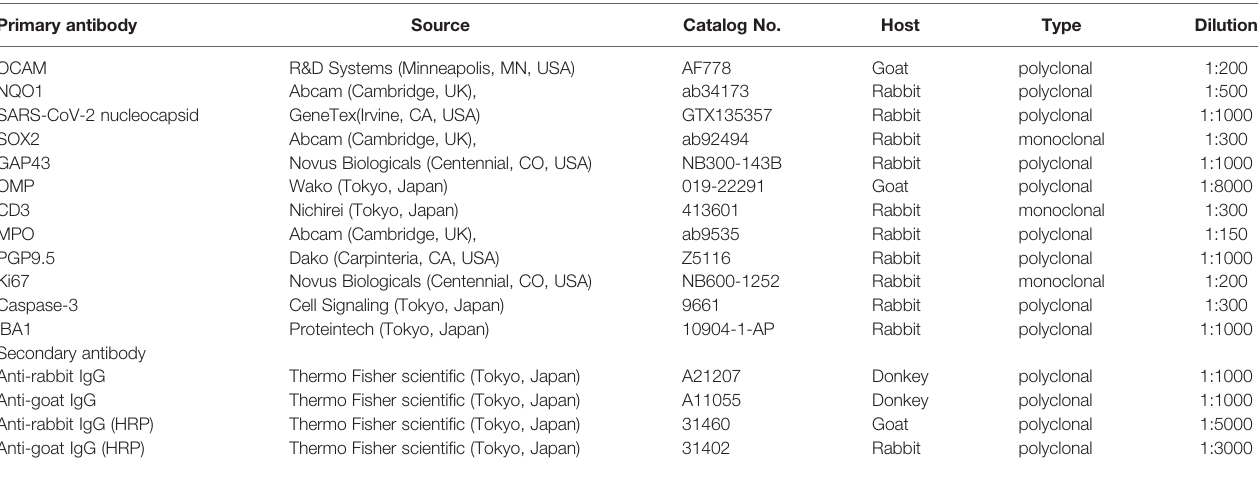
TABLE 1 | The primary and secondary antibodies used in this